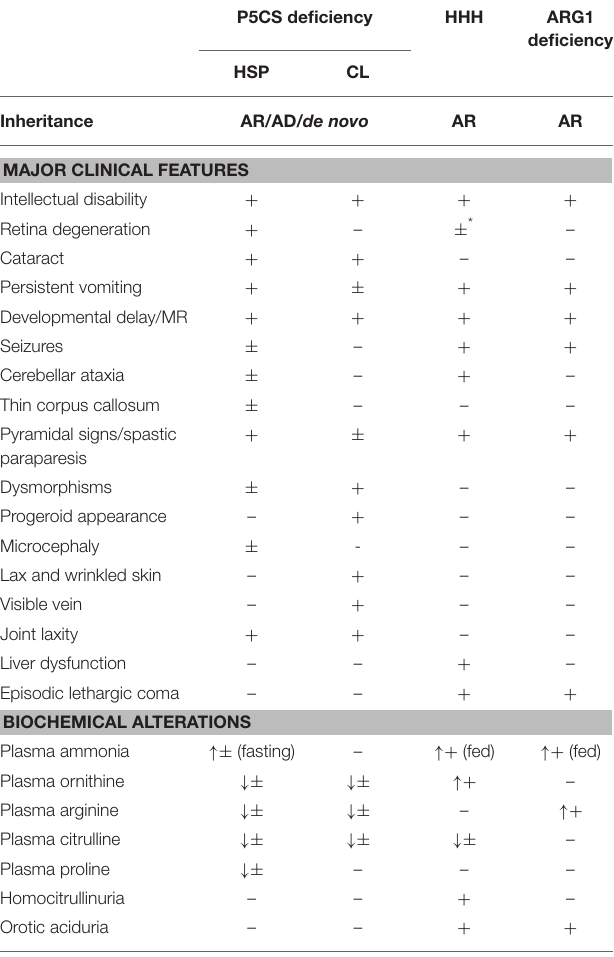
TABLE 1 | Main features found in P5CS deficiency, ARG1 Deficiency, and HHH